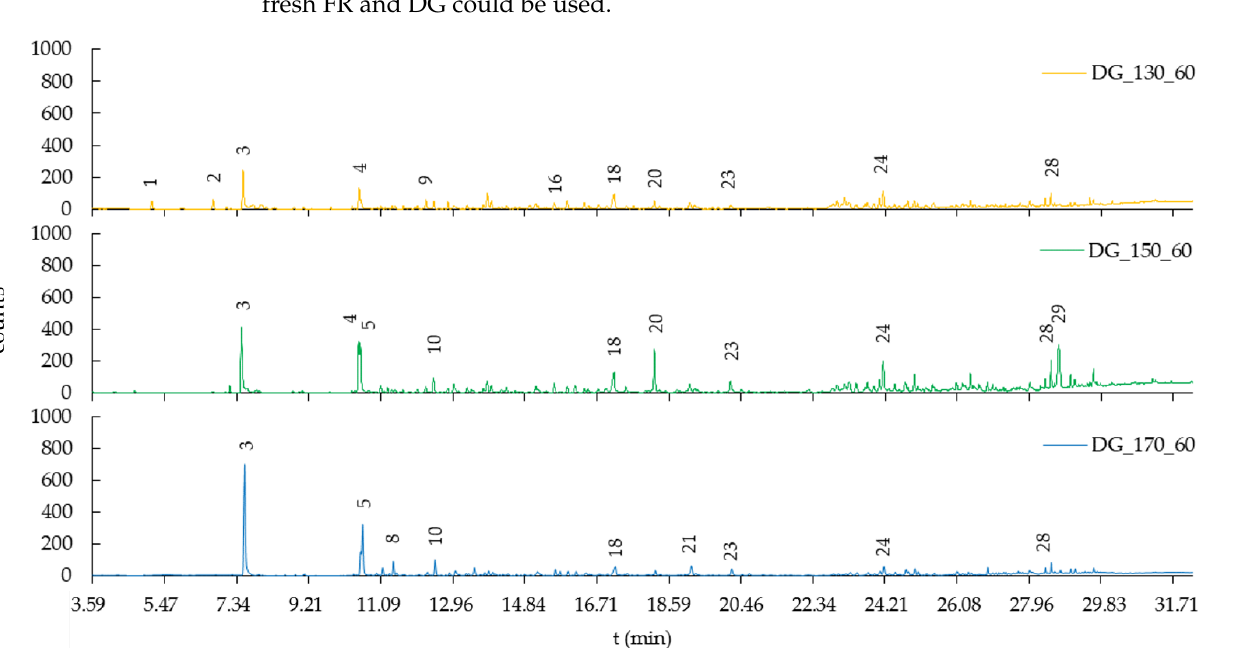
Figure 2. GC-MS diagram of the digestate (DG) hydrothermally treated at 130 °C with 30, 60 and 90 min holding times, see peak numbers in Table 6.